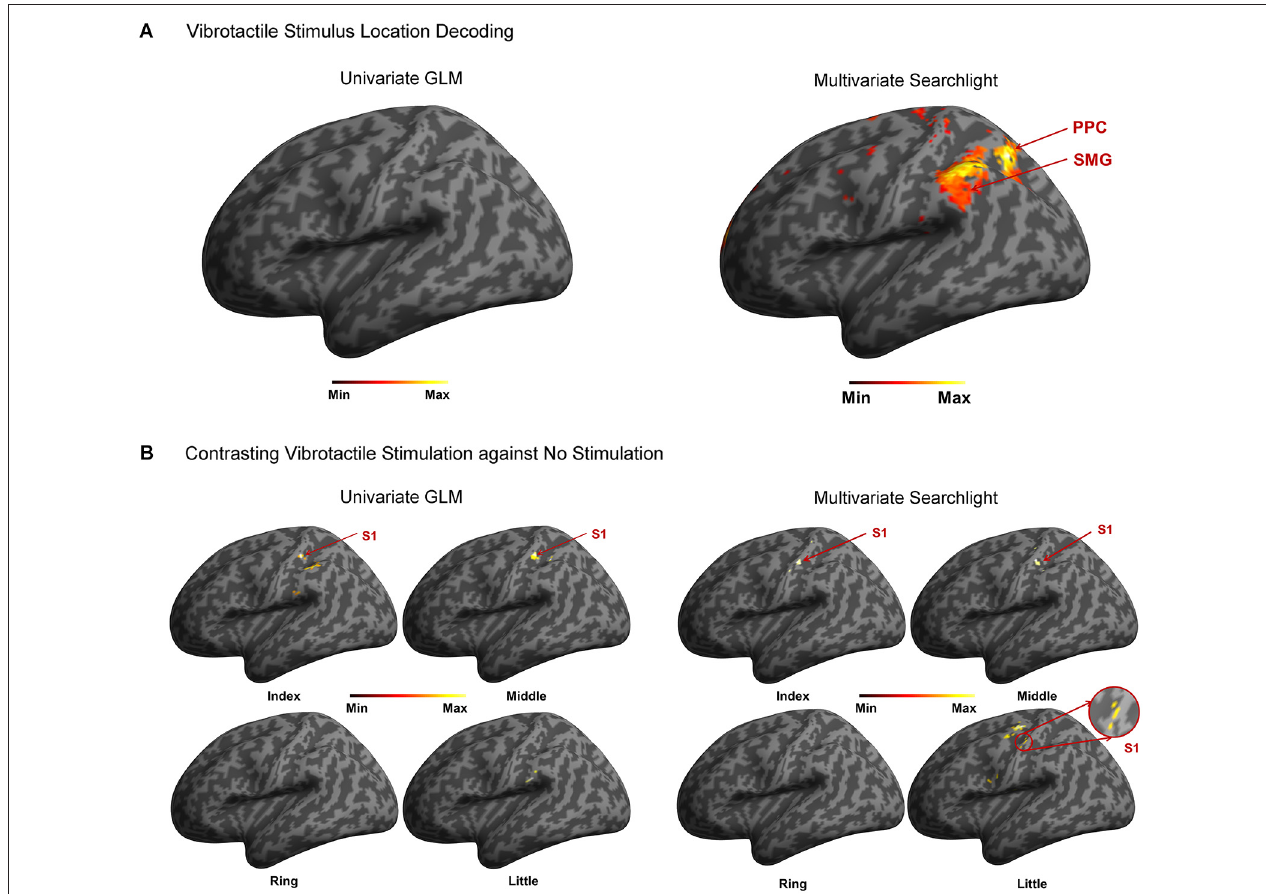
FIGURE 2 | Summary of the analysis. (A) In the stimulated finger decoding analysis, searchlight MVPA found two significant clusters located in contralateral PPC and SMG. However, no significant cluster was found from univariate GLM approach. (B) In the contrast analysis of finger